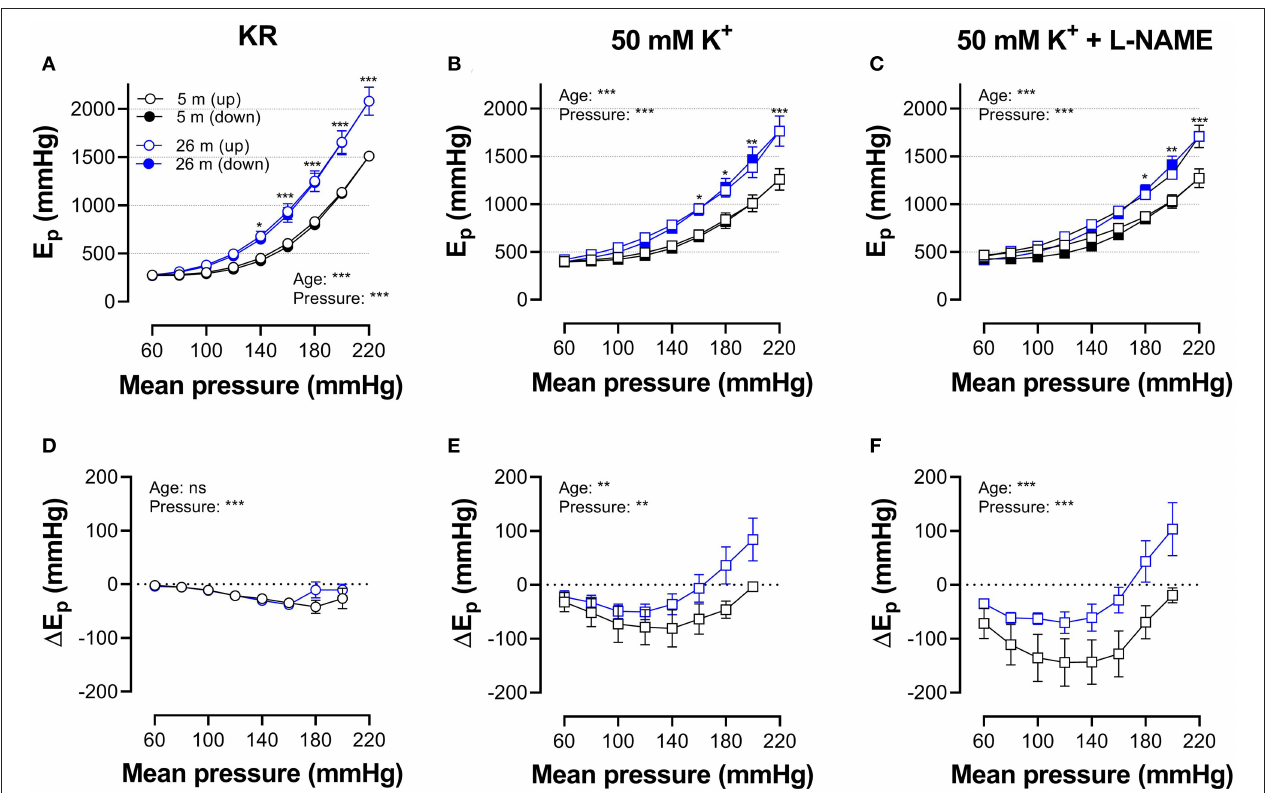
FIGURE 6 | Hysteresis is pressure, contraction, and age dependent. Aortic segments of mice aged 5 months (black, n = 8) and 26 months (blue, n = 5) were subjected to upward (open symbols, up) and downward (closed symbols, down) pressure steps between 40 and 80mm Hg to 180–220 or 200–240mm Hg and back in control conditions (KR, A,D ) in the presence of 50mM K + (B,E) and 50 mMK + in the presence of 300- µ M L-NAME to block endothelial NO release (C,F) . Absolute values of E p are shown in (A–C) , whereas, in (D–F) , data points for the upward pressure steps (open symbols, up) were compared at any given pressure with data points for the downward pressure steps (closed symbols, down) (stiffness hysteresis). Two-way RM ANOVA with Sidak’s multiple comparison test (old vs. young mice),